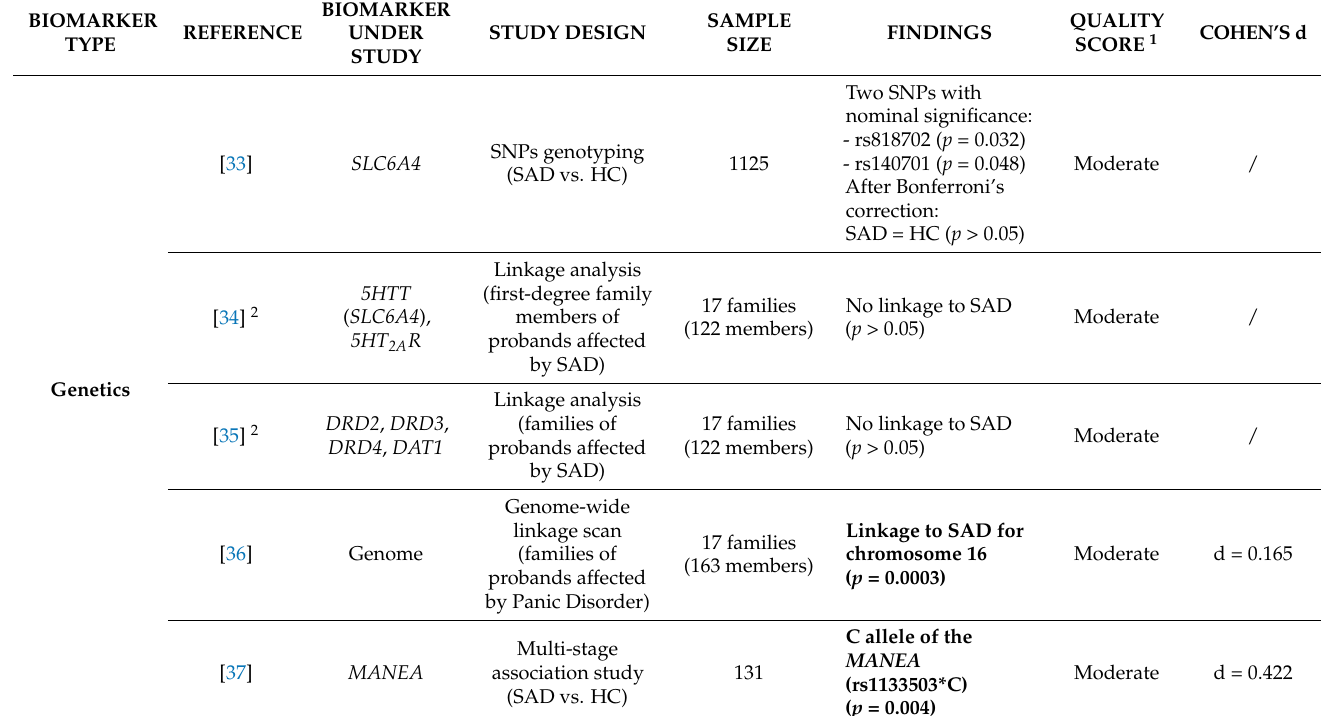
Table 1. Summary of evidence regarding genetic and epigenetic biomarkers of